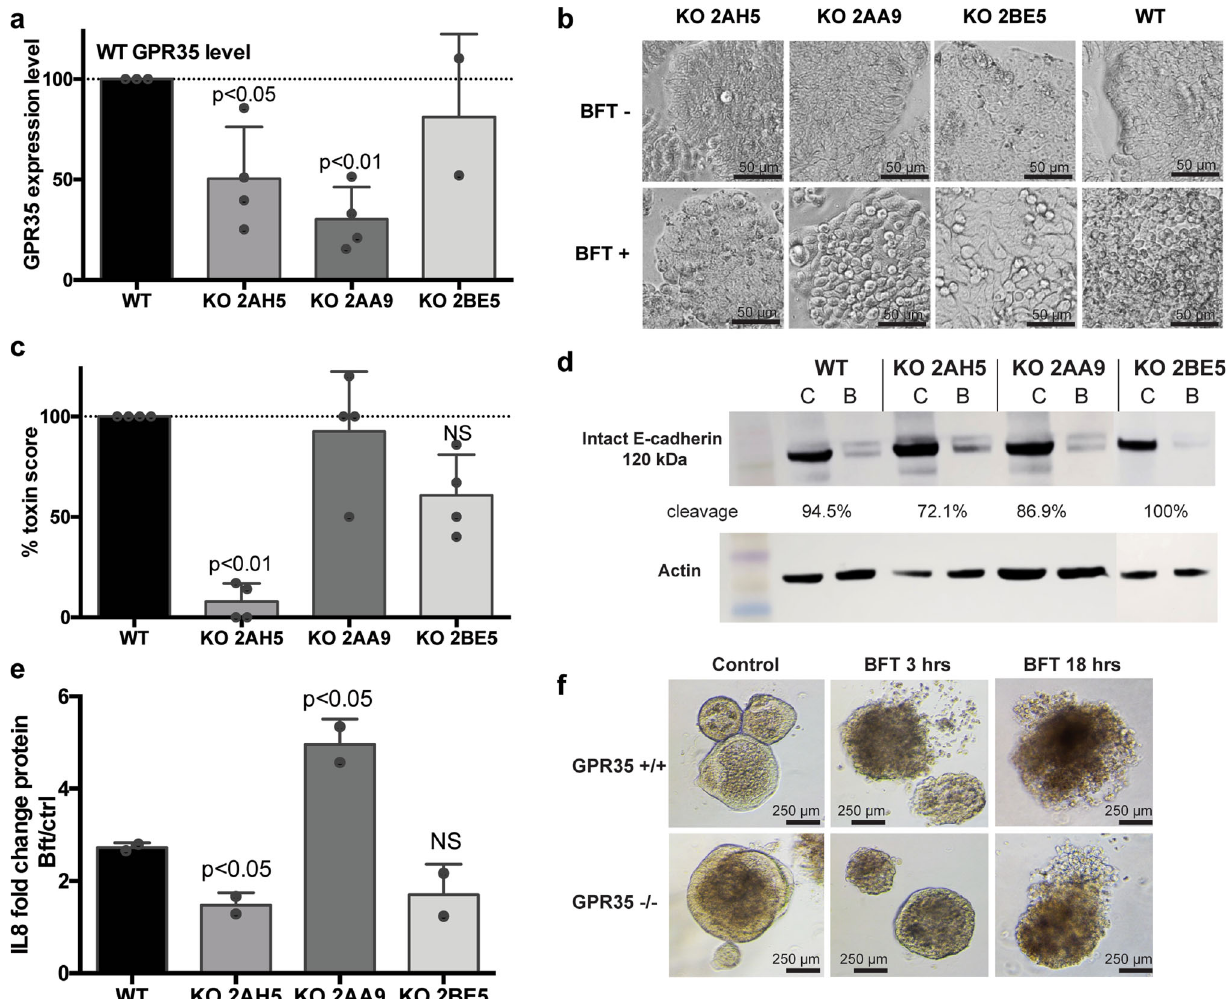
Fig. 4 GPR35 knockout in HT29/c1 cells and mouse organoids results in delayed BFT response. a CRISPRcas KO of GPR35 in three con fi rmed clones 2AH5, 2AA9, and 2BE5 resulted in reduced GPR35 mRNA expression levels for 2AH5 ( N = 4, P < 0.05) and 2AA9 ( N = 4, P < 0.01) but not for 2BE5 ( N = 2). b , c Morphology changes following BFT treatment in CRISPRcas KO were only reduced for clone 2AH5 but not for 2AA9 and 2BE5. d E-cadherin cleavage, determined through western blotting, was reduced to 72% in 2AH5 compared to 94.5% in WT HT29/c1 cells, but was not totally inhibited. A representative western blot and corresponding actin controls are depicted ( N = 3). e The fold change of IL-8 secretion in BFT-treated versus nontreated control cells was signi fi cantly reduced only for the CRISPRcas KO cell line 2AH5 ( N = 2, P < 0.05). f Enteroids derived from the WT and GPR35 − / − distal mice colon exposed to BFT show a delayed change in morphology at 3h after treatment with BFT in the GPR35 − / −